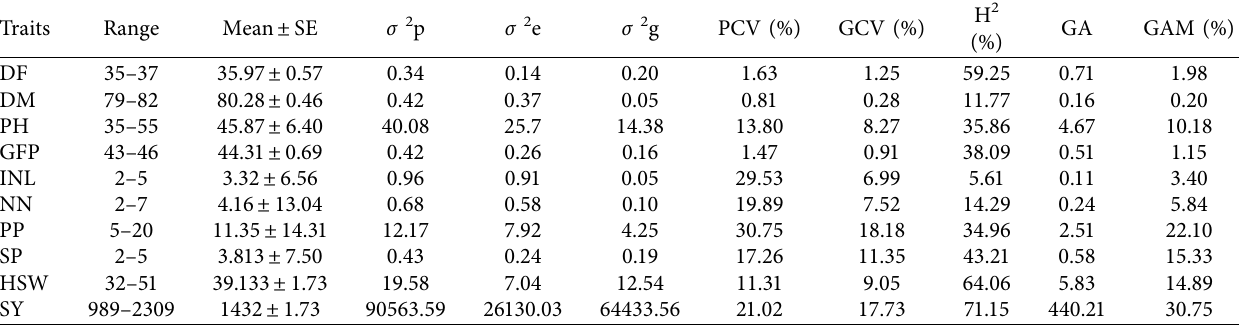
Table 4: Estimate of range, mean, variance components, heritability, and genetic advance of common bean genotypes at MARC in 2018 cropping season.